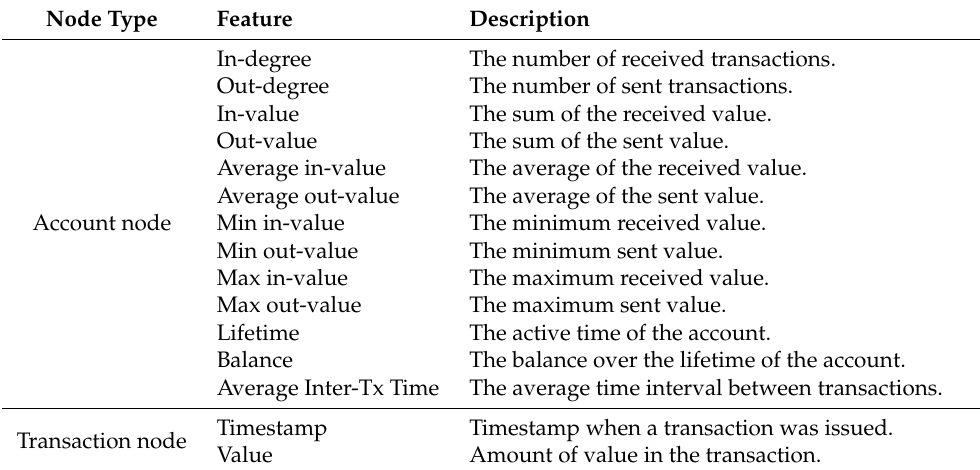
Table 1. The description of node features.